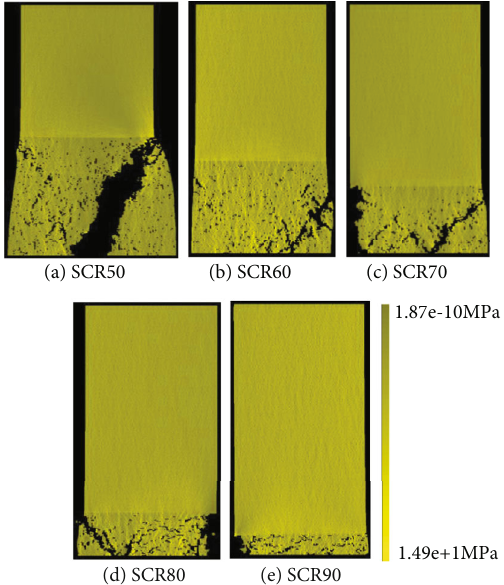
Figure 4: Fracture patterns of samples with di ff erent coal and rock height ratios after adding water pressure.